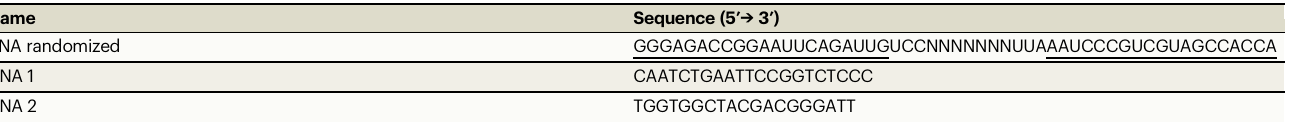
Table 1 | Substrates for HiTS-Eq measurements